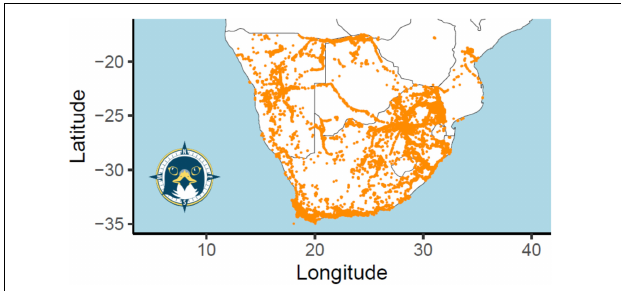
FIGURE 1 | Locations of observations of flying raptors (orange points) in southern Africa within the Global Raptor Impact Network database.